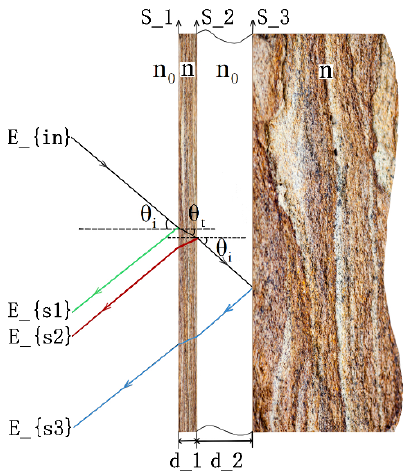
Figure 1. Schematic illustration of hollowing deterioration of stone relics and the terahertz (THz) wave reflection single-point thickness extraction principle of the hollowing model. E_{in} is the incident field; E_{s1}, E_{s2}, and E_{s3} are the fields reflected from the front and back flaked stone surfaces and the stone wall surface, respectively; d_1 and d_2 are the flaked stone and hollowing sample thicknesses, respectively; θ i and θ t are the incidence and refraction angles, respectively; and n and n 0 are the refractive indexes of the flaked stone sample and air, respectively.